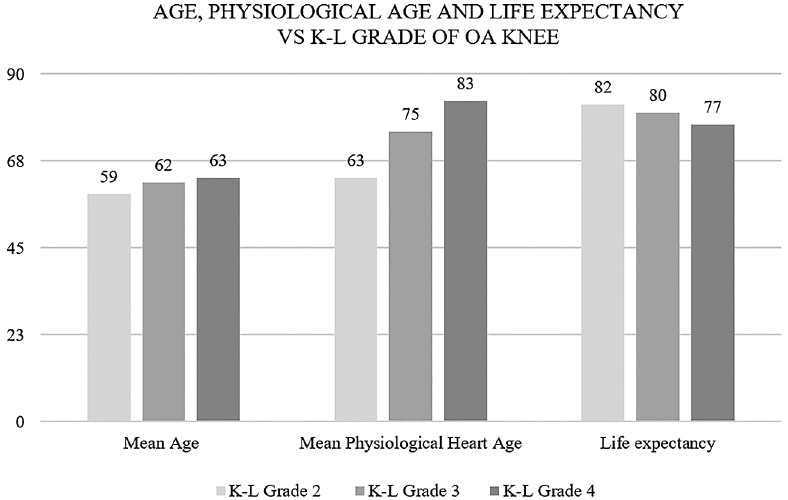
Figure 3. As we go up the K-L grade of knee OA, the physiological heart age went up and the life expectancy came down.